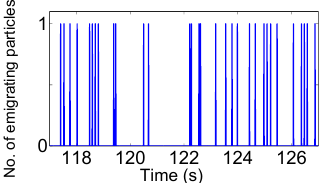
Figure 4. Example time series of emigration events for Q i = 40MPM. A position x along the bed viewing window (as seen in Fig. 1) is monitored during the experimental run. When a particle passes position x , it is considered an emigration event. This is a simple measure of particle activity that can be converted into a time- averaged flux. Time series of emigration sampled at a fixed position x along the bed were determined for all experimental runs.